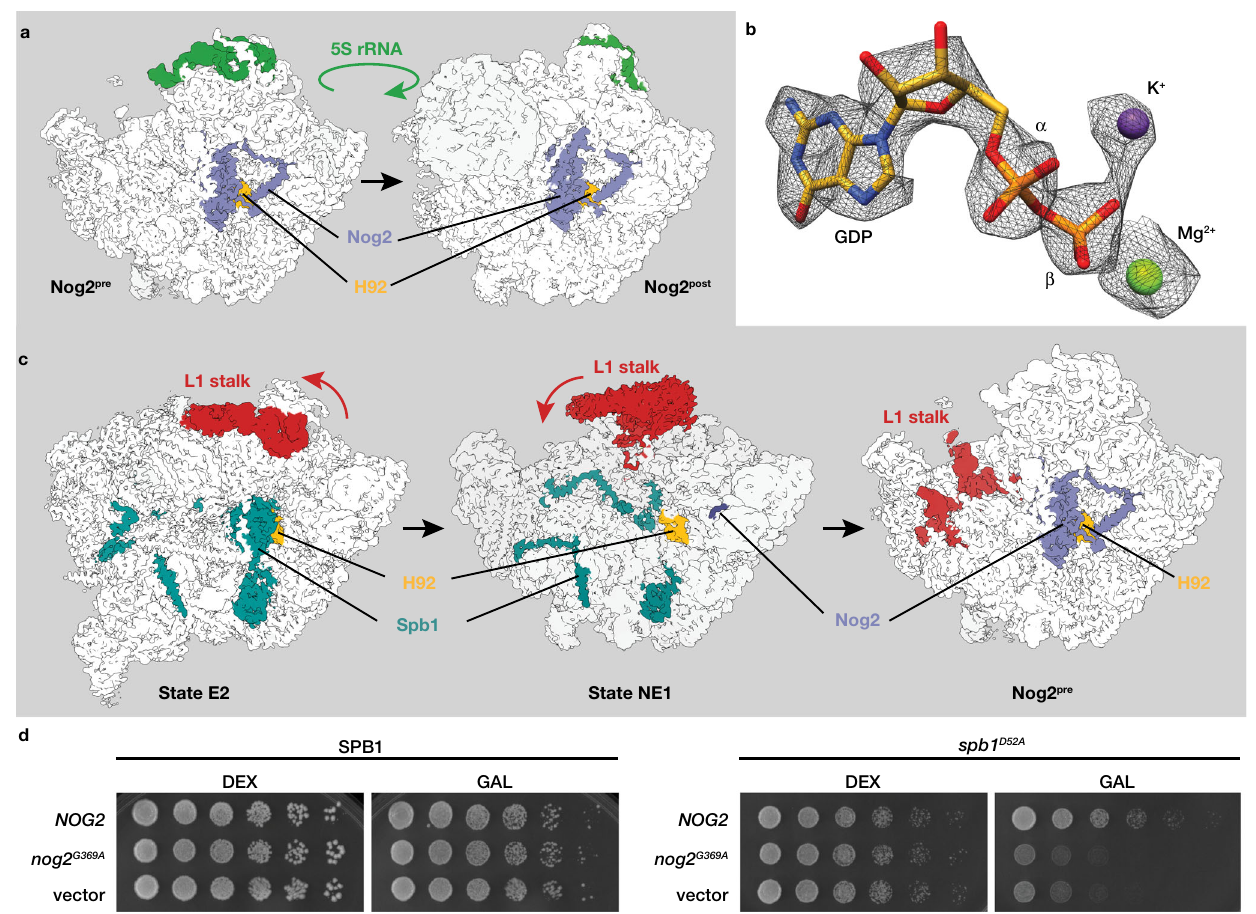
Fig. 3 | Premature GTP hydrolysis does not affect late nucleoplasmic 60S maturation but prevents the ef fi cient formation of early nucleoplasmic intermediates. a Low-pass- fi ltered maps (4.5Å) of Nog2 pre and Nog2 post , puri fi ed from the spb1 D52A strain highlighting the position of Nog2 (blue) and 5S rRNA (green) in its pre- and post-rotation states. b Map density in the Nog2 active site from Nog2 post particles puri fi ed from the spb1 D52A strain, showing clear occupancy by GDP. c Low pass fi ltered maps (4.5Å) of pre-60S structures showing the tran- sition between Spb1 and Nog2-containing intermediates near the nucleolar/ nucleoplasmic boundary. The transition is precipitated by the catalytic activity of theATPaseRea1andismarkedbythemovementanddockingoftheL1stalk(shown